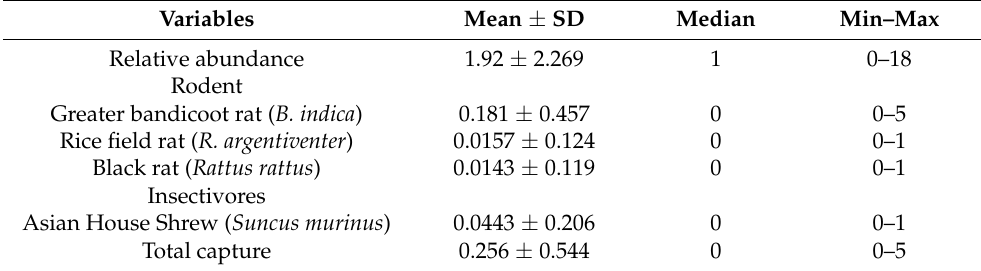
Table 3. Summary statistics for rodent